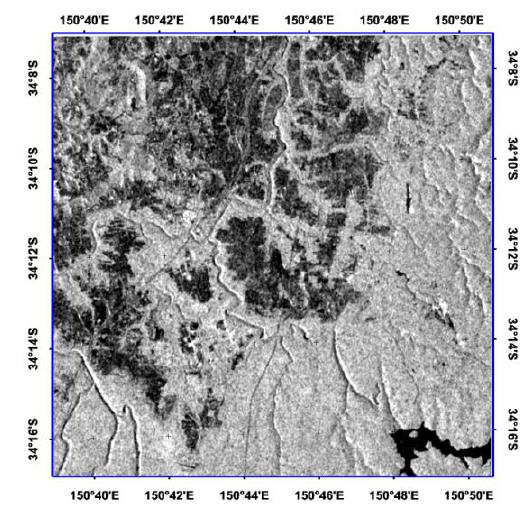
Figure 1. ENVISAT/ASAR VV polarized image acquired on